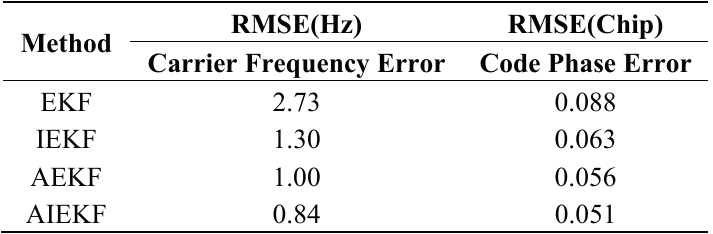
Table 2. Code phase and carrier frequency errors of the EKF, IEKF and AIEKF